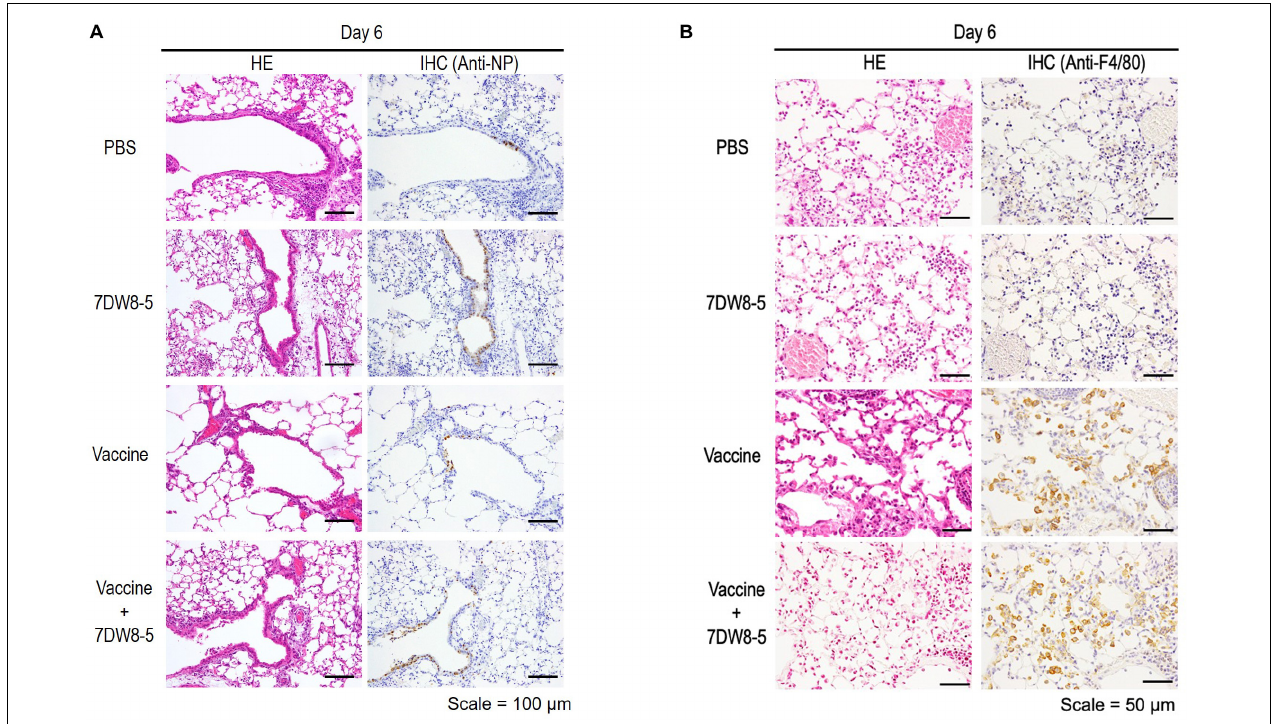
FIGURE 3 | Pathological analysis of the lungs of immunized mice after challenge. Six-week-old BALB/c mice ( n = 3) were immunized with PBS, 7DW8-5 (10 µ g/dose), HA vaccine alone, or HA vaccine plus 7DW8-5 (10 µ g/dose) twice with a 2-week interval between vaccinations. The immunized mice were intranasally challenged with 10 MLD 50 of MA-CA04 virus 3 weeks after the second immunization. The lungs were fixed with 4% PFA buffer solution on day 6, and stained as described in the Materials and Methods section. HE, hematoxylin and eosin staining; IHC, immunohistochemistry for the detection of influenza virus NP antigen (A) or anti-F4/80 antibody (B) . Scale bars: 100 µ m (A) and 50 µ m (B) .